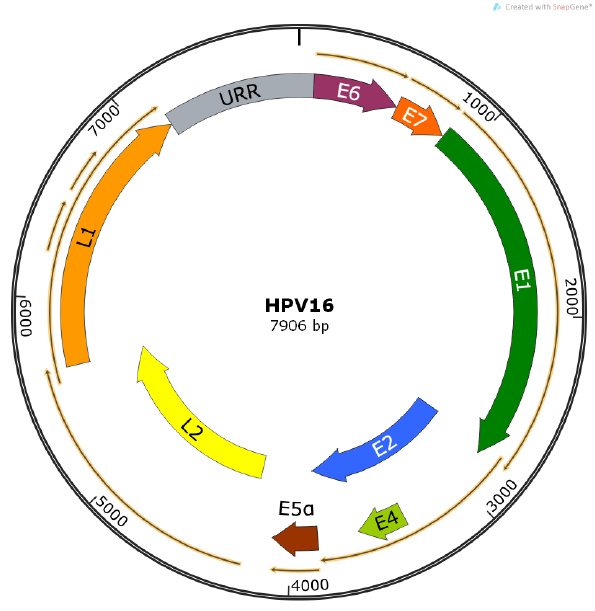
FIGURE 1: HPV16 genome showing viral open reading frames coding for known viral proteins. The Upstream Regulatory Region (URR) is shown in grey. Map constructed using SnapGene soft-